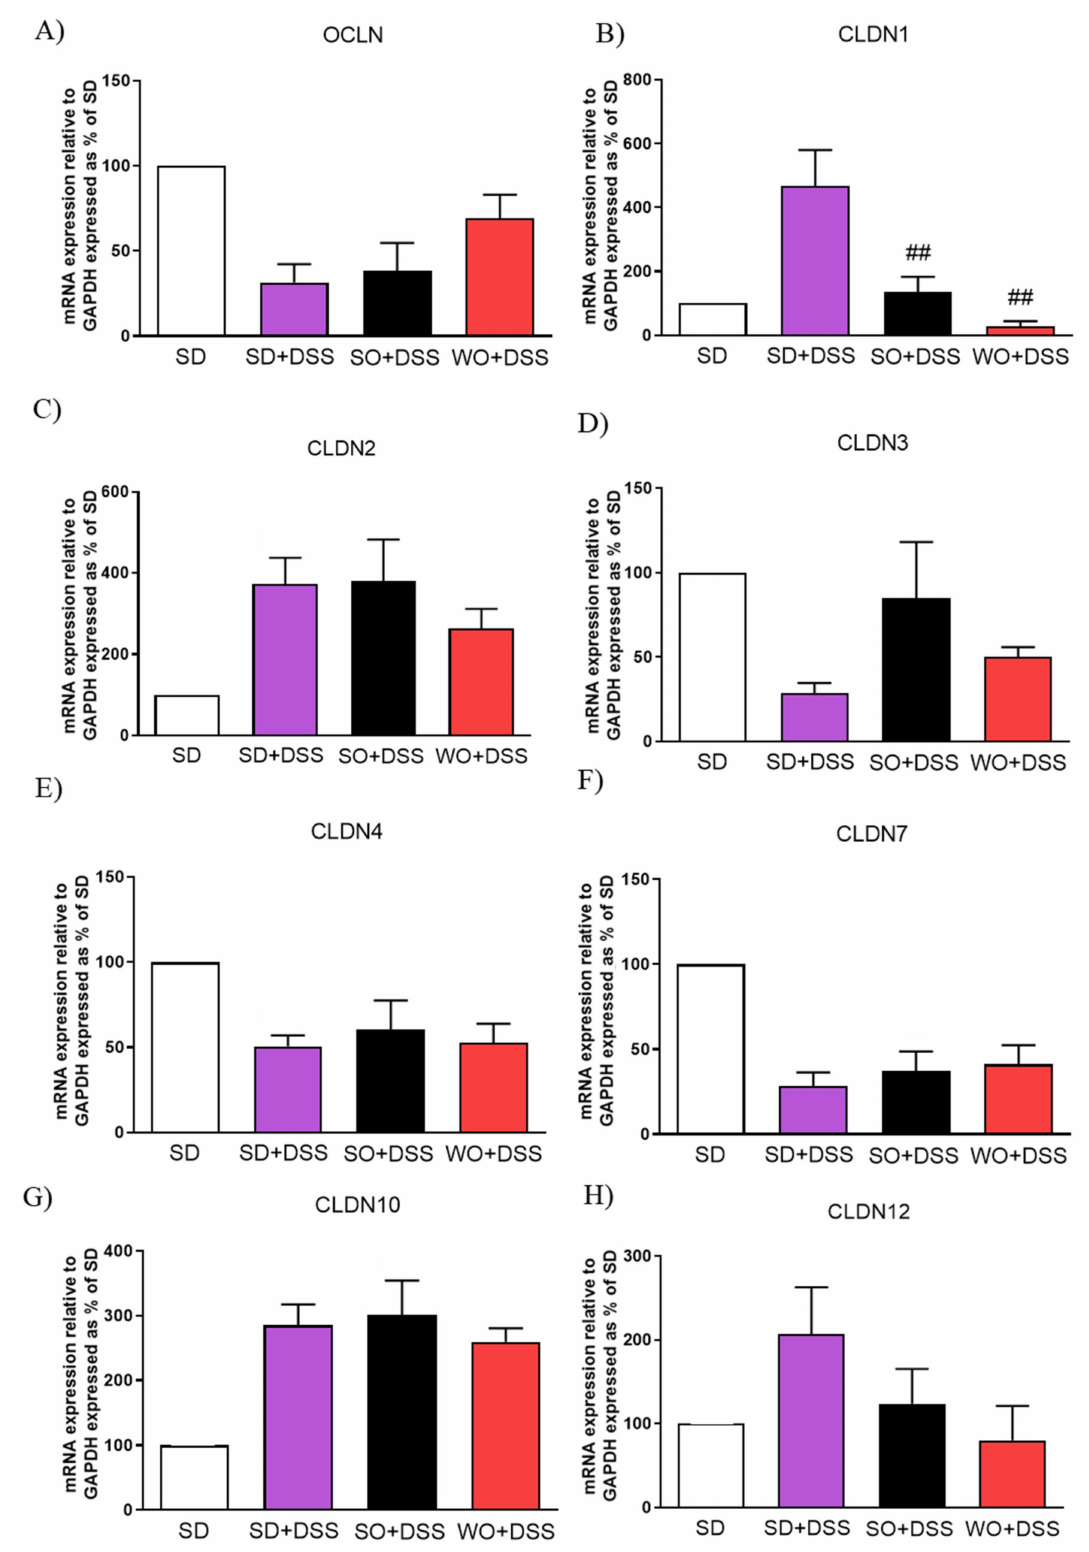
Figure 7. Changes in tight junction genes expression ( A–H ) in the colon of mice treated with DSS and fed with standard diet (SD), sunflower oil (SO), and walnut oil (WO). Values expressed as percent of control group. Data represent mean ± SEM, n = 8–12. ## p < 0.01, as compared to